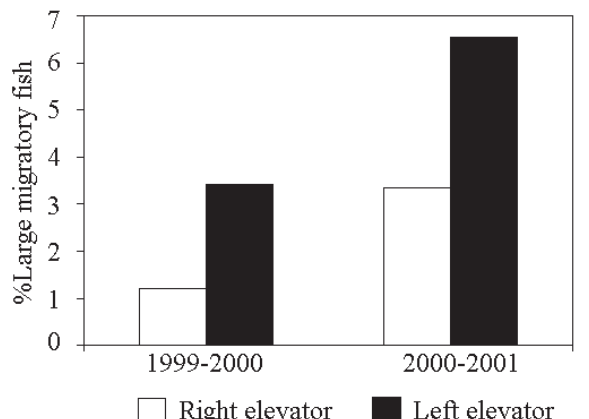
Fig. 3. Percentage of target species in the right and left eleva- tors in Yacyreta Dam.